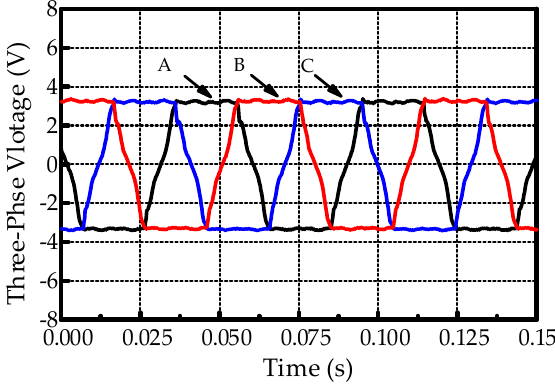
Figure 24. The waveform of three-phase voltage.